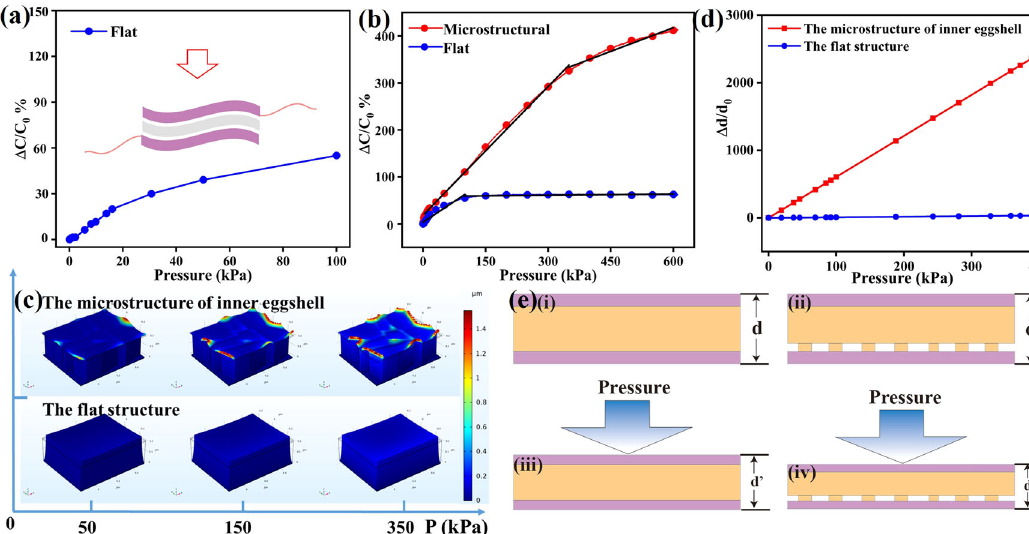
Fig. 3 Comparison of the fl at and micro-structured sensors. a Capacitance changes of the fl at sensor under the external pressure within 100 kPa; b Sensitivity comparison of the fl at and micro-structured sensors within the range of 0 – 600 kPa; c Schematic diagram of the two sensors under the external pressure from Comsol simulation; d Compression displacement comparison of the two sensors; e Schematic diagram of the changes in the two sensors ’ distance and contact area under a given